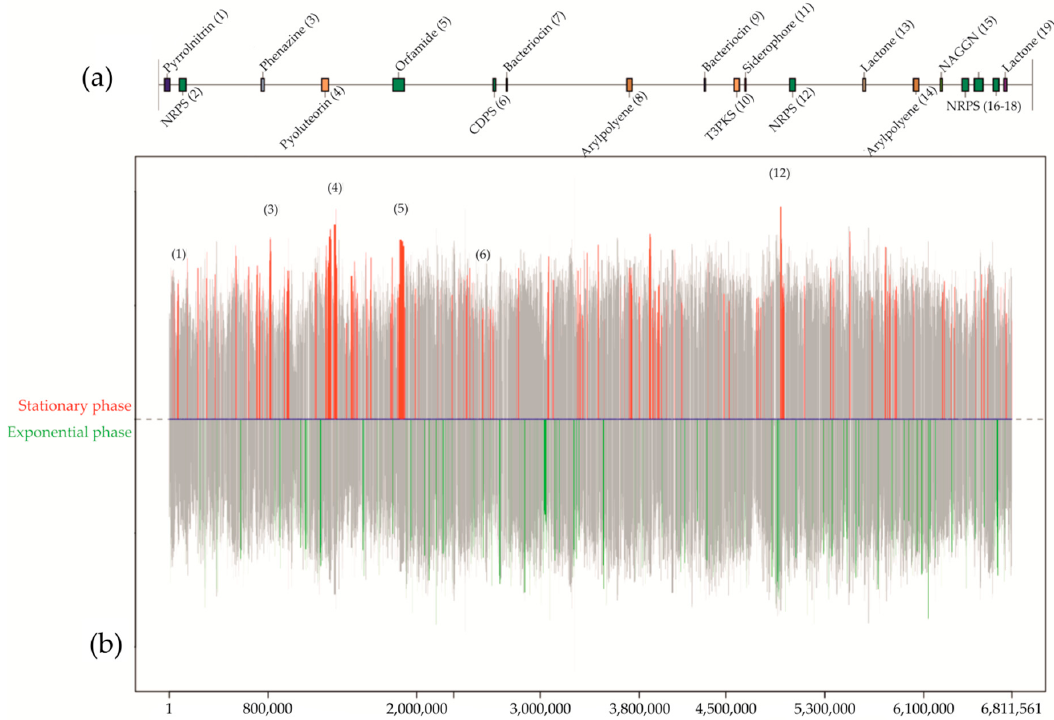
Figure 3. Graphic example from a di ff erential gene expression analysis for Pseudomonas sp., isolated from a mine in Lousal (Portugal). Culturing conditions were established in solid medium with nutrient agar and 2% of glycerol. The prediction and location of the biosynthetic gene clusters in the 6.8 Mbp genome ( a ) were used to map the di ff erentially expressed genes ( b ) between the stationary phase and the exponential along the chromosome. Colored peaks represent the variability of expressed genes between both conditions with a 99% of probability. Red peaks show those genes di ff erentially expressed in the stationary phase, in opposition to the green peaks, which are referred to the di ff erential expression in the exponential phase. Grey peaks represent those genes di ff erentially expressed below the 99% threshold, or simply not di ff erentially expressed between conditions. From the predicted secondary metabolites, only six of them were di ff erentially expressed in the stationary phase. Considering the bioactivity analyses in this medium and the study of antibiotic resistance mechanisms on genomes of pathogenic bacteria, no expression of genes involved in the synthesis of antibiotics against Gram-negative bacteria occurred for the described solid media culture.